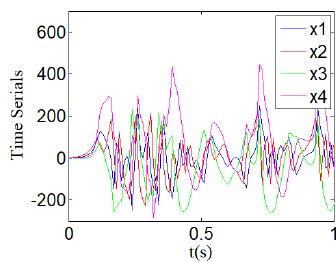
Figure 7. The hyperchaotic system time series diagrams with parameters a = 50, b = 26, c = 13, d = 8, e = 33 and f =